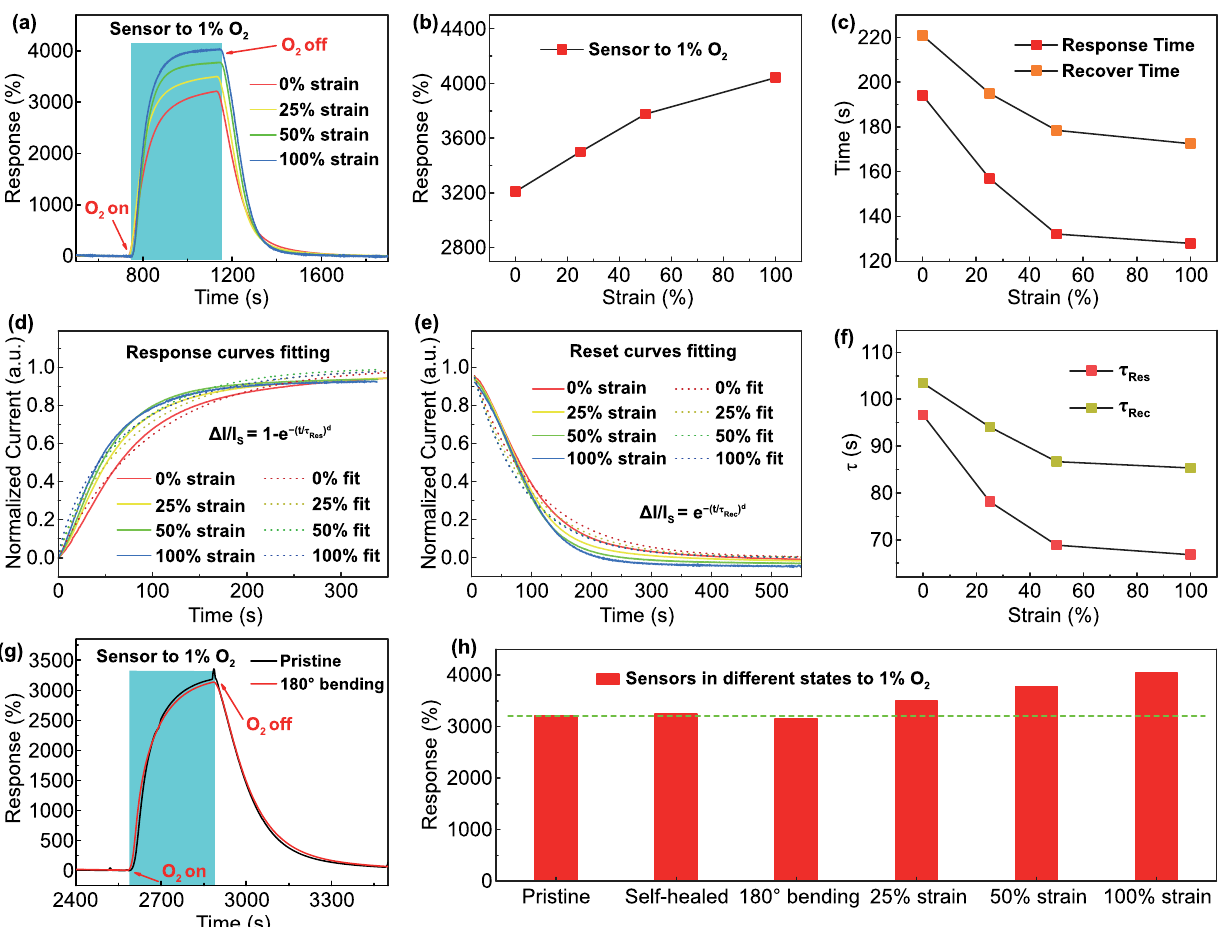
Fig. 4 Influence of deformation on O 2 sensing properties of organohydrogel sensor. a Dynamic response curves to 1% O 2 at 0%, 25%, 50%, and 100% tensile strains. b Response extracted from a versus strain. c Response and recovery time t 90 extracted from a versus strain. d Normalized current variations in response to 1% O 2 at different strains with fits to the exponential growth formula. e Normalized current variations in the recovery process with fits to the exponential decay formula at different strains. f Plots of time constants ( τ Res and τ Rec ) versus tensile strain. g Real-time responses to 1% O 2 in pristine and 180° bending states. h Quantitative responses to 1% O 2 in the states of pristine, self-healed, 180° bending, 25%, 50%, and 100% tensile